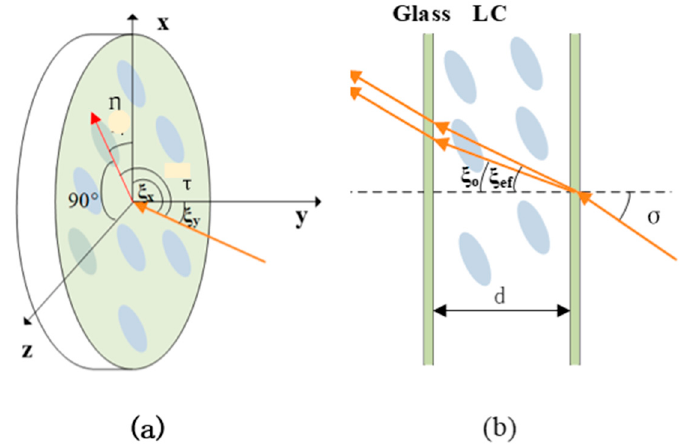
Figure 5. ( a ) Schematic diagram of the internal structure of LCVR under oblique incident light. ( b ) Schematic diagram of the refraction phenomenon that occurs when incident light is obliquely inci- dent LCVR.